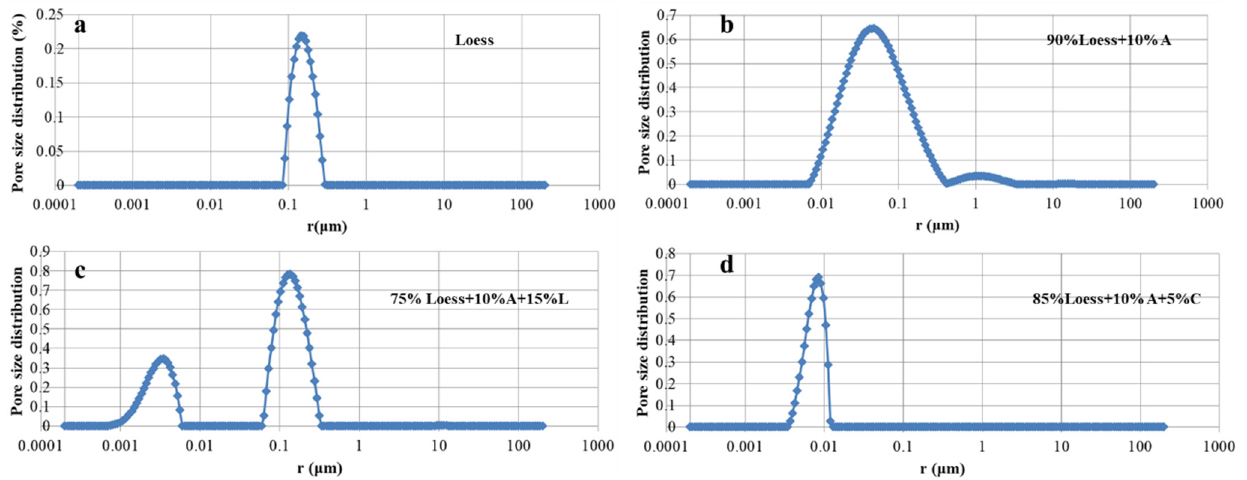
Figure 4. NMR test results. (A means attapulgite, L means lime, and C means cement). ( a ) Loess, ( b ) 90%Loess+10%A, ( c ) 75%Loess+10%A+15%L, ( d ) 85%Loess+10%A+5%C.